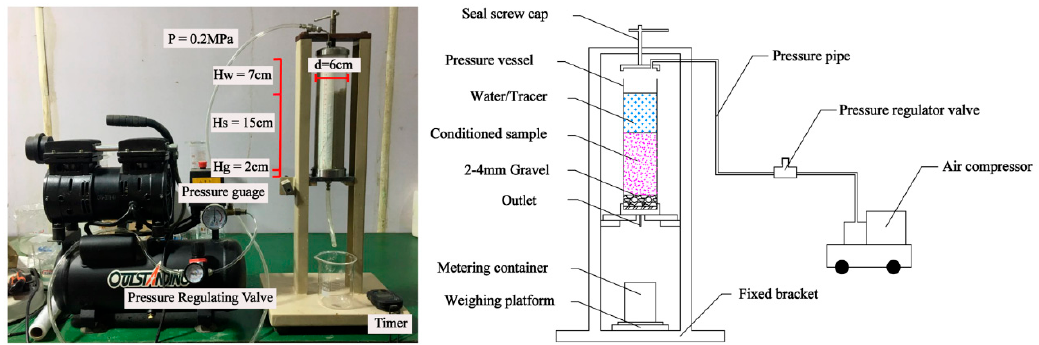
Figure 2. Permeability test device. 253